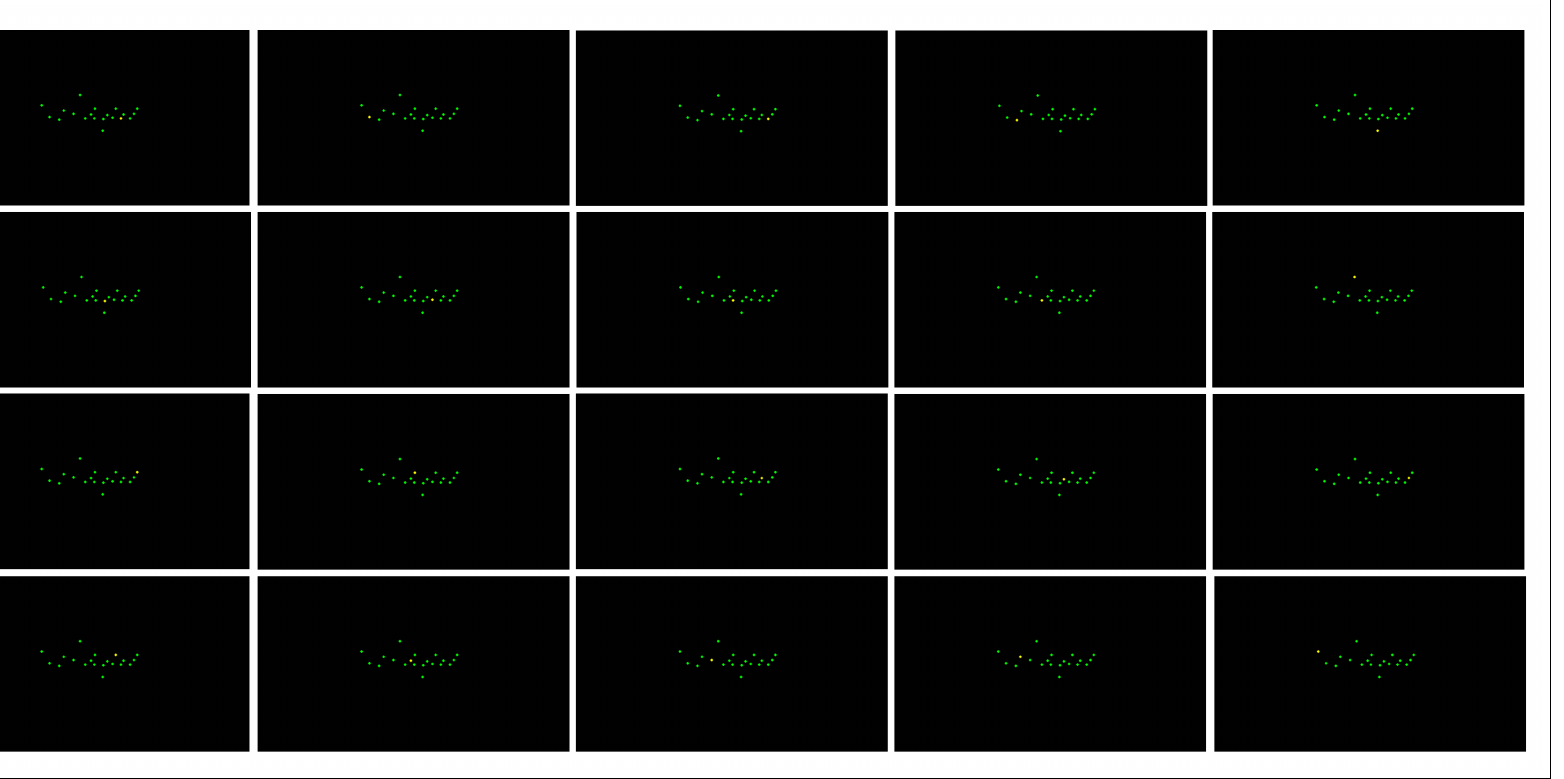
Figure 6. Player labeling data—cycling through all of the players, we identify a single player at a time as the desired player to label. This player is colored yellow while all other players are colored green. A slight gradient is applied to the circular marks of all of the players to better handle players that are very close to each other, causing the marks to